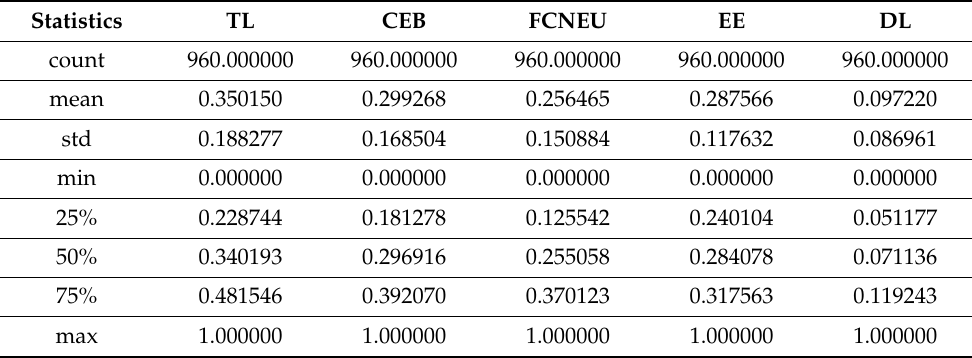
Table 1. The input variables of the model. Table 2. Statistical description of the